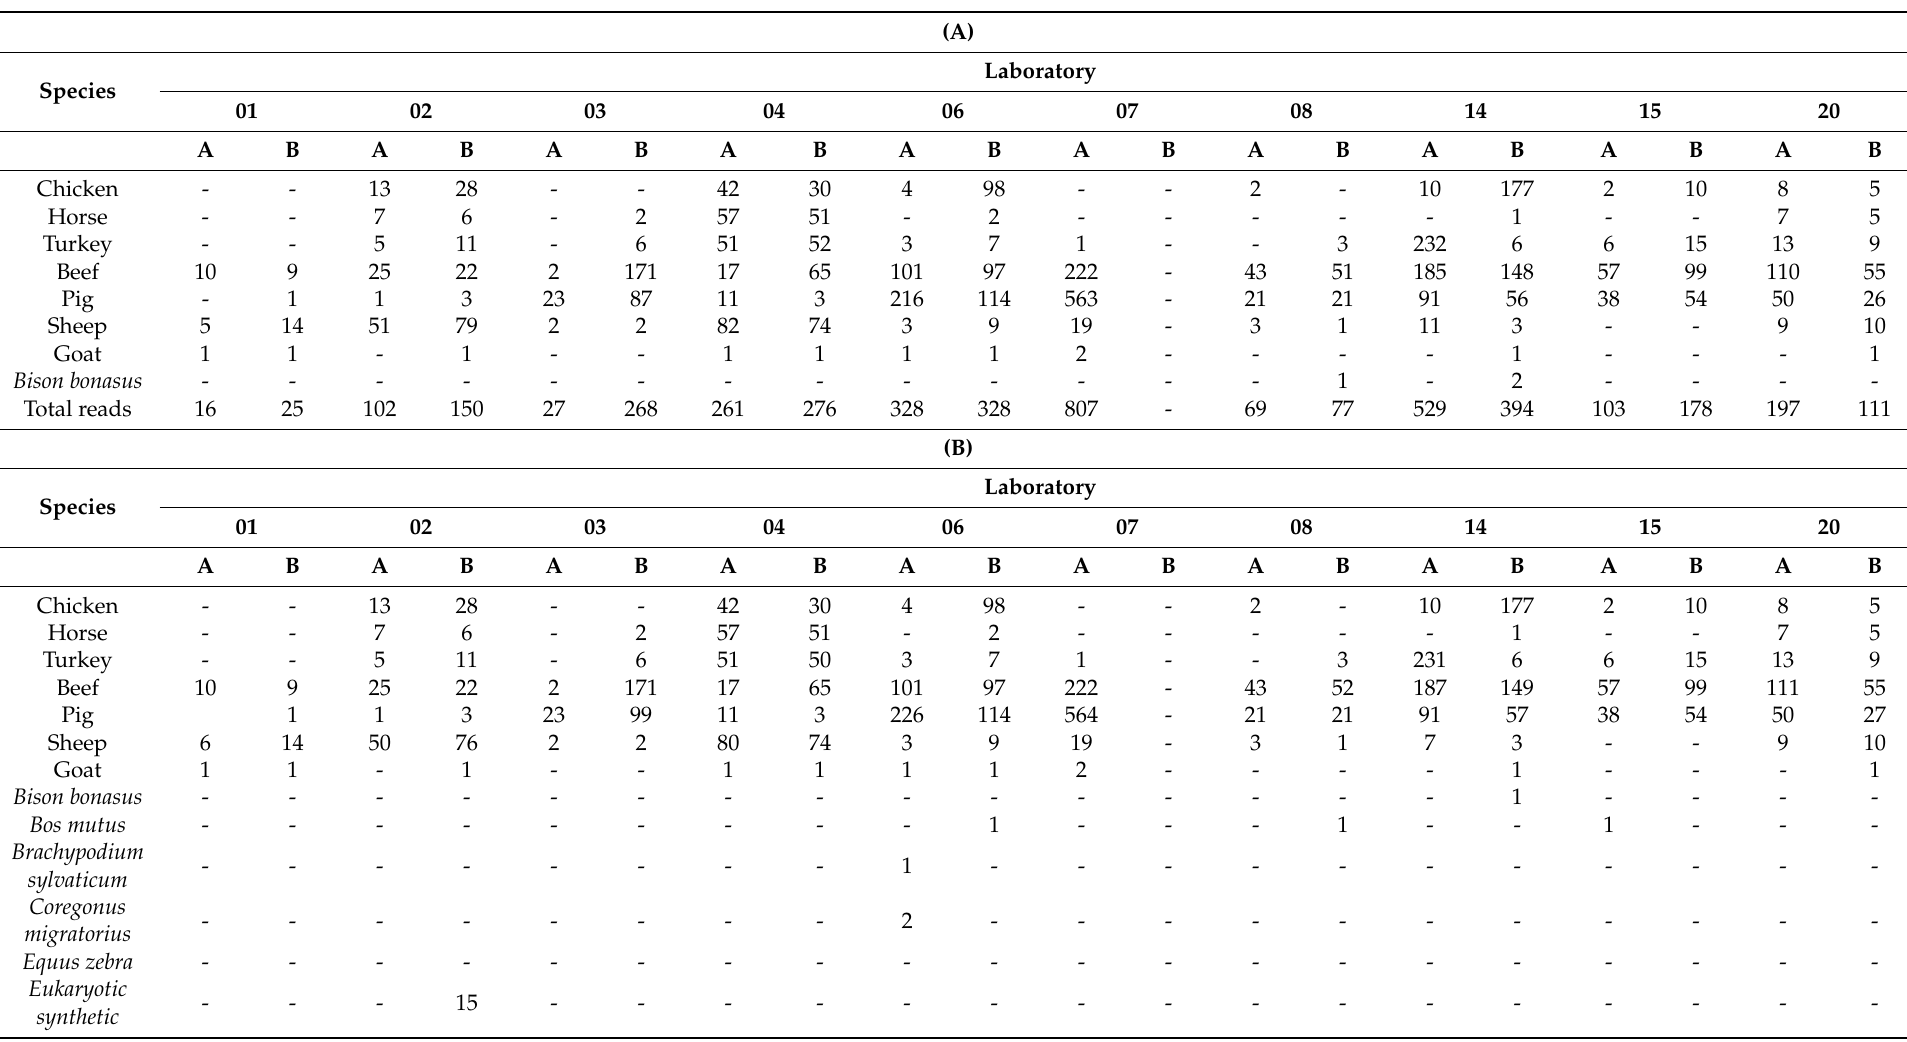
Table 8. Reads obtained for sample 8 (negative control). ( A ): AGES database, ( B ): NCBI